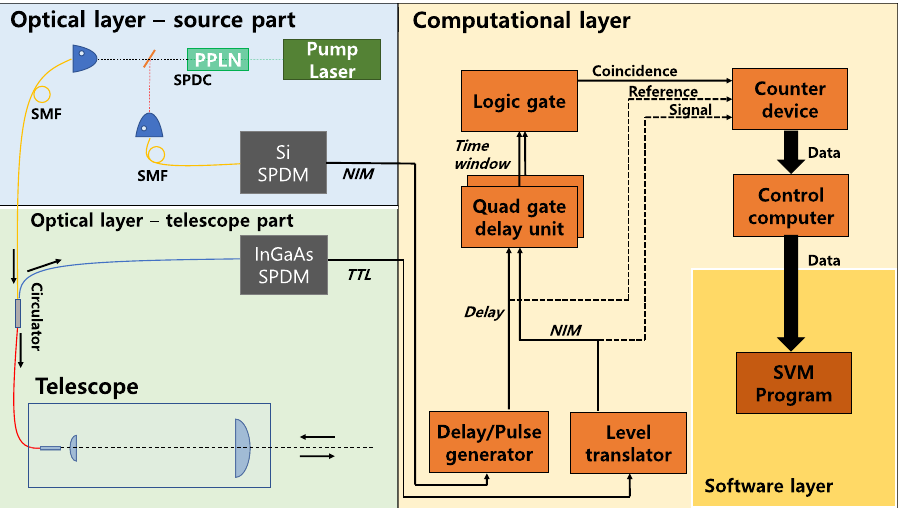
Figure 2. A schematic diagram of the whole experimental set up.